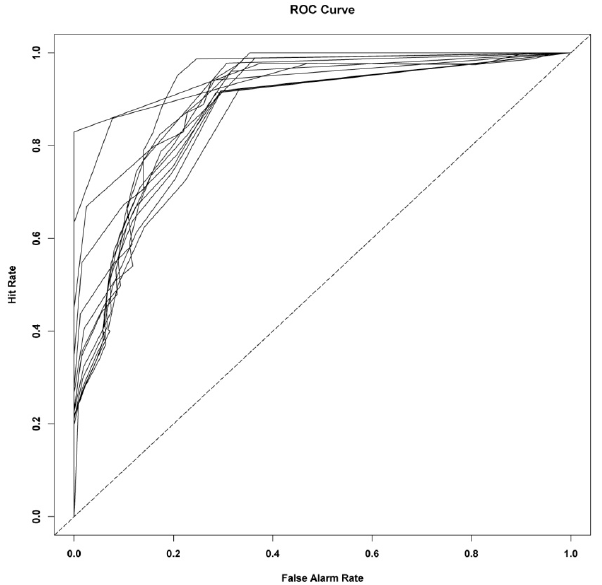
Fig. 6. ROC plot from the forecasts based on decile categorical thresholds for all the 14 streamflow and rainfall stations.